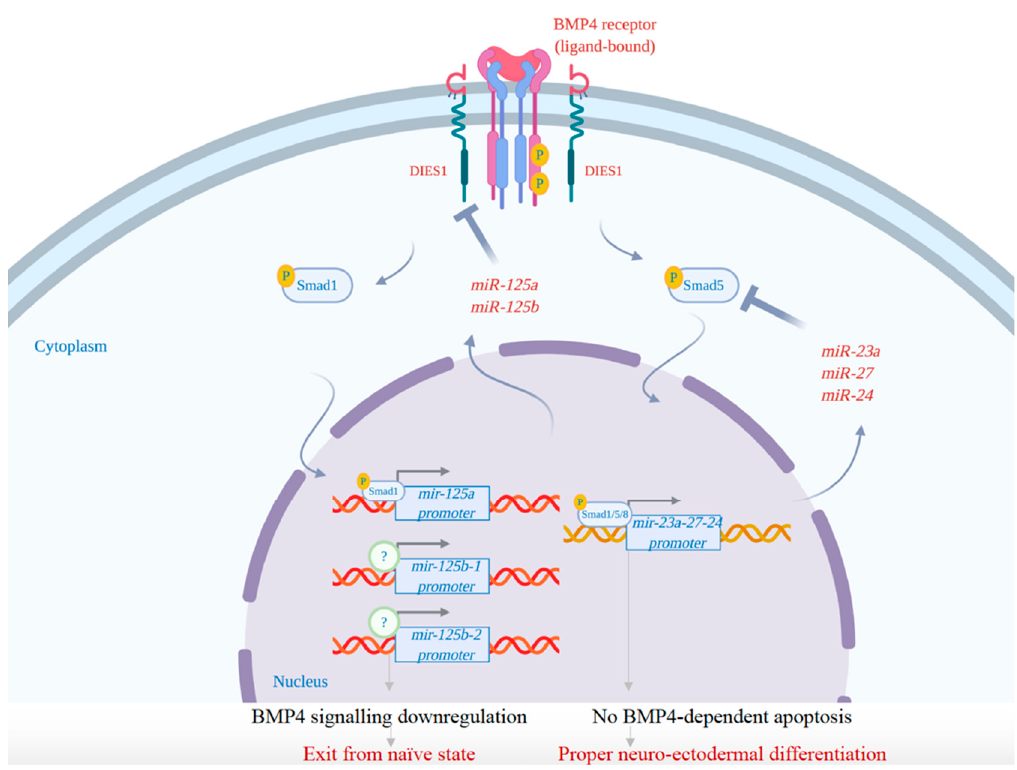
Figure 3. Feedback loop on BMP4 pathway mediated by miR-125a/b and miR-23a-24-27a during both the exit of mESCs from naïve state and their neuroectodermal differentiation. Briefly, miR-125a and miR-125b control the exit from the naïve state by targeting the BMP4 co-receptor Dies1, causing BMP4 pathway downregulation. In parallel, the mir-23a-24-27a cluster blocks the apoptotic response of mESCs to BMP4 signaling by targeting Smad5 and allowing the proper differentiation of the neuroectodermal precursors.